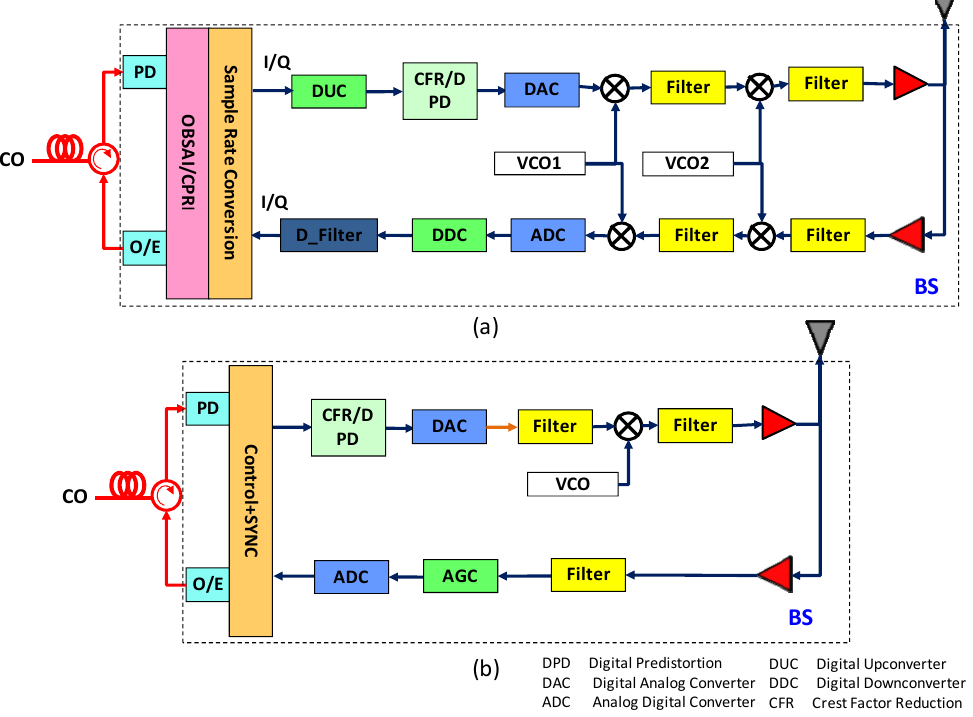
Figure 3. Possible base station configuration for ( a ) digitized IF-over-Fiber transport and ( b ) digitized IF-over-Fiber transport incorporating bandpass sampling